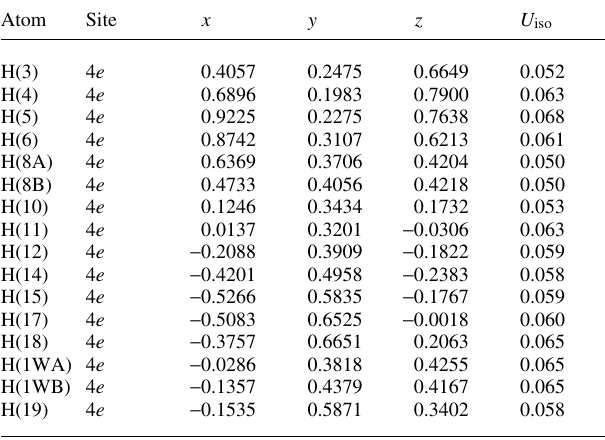
Table 2. Atomic coordinates and displacement parameters (in Å 2 )